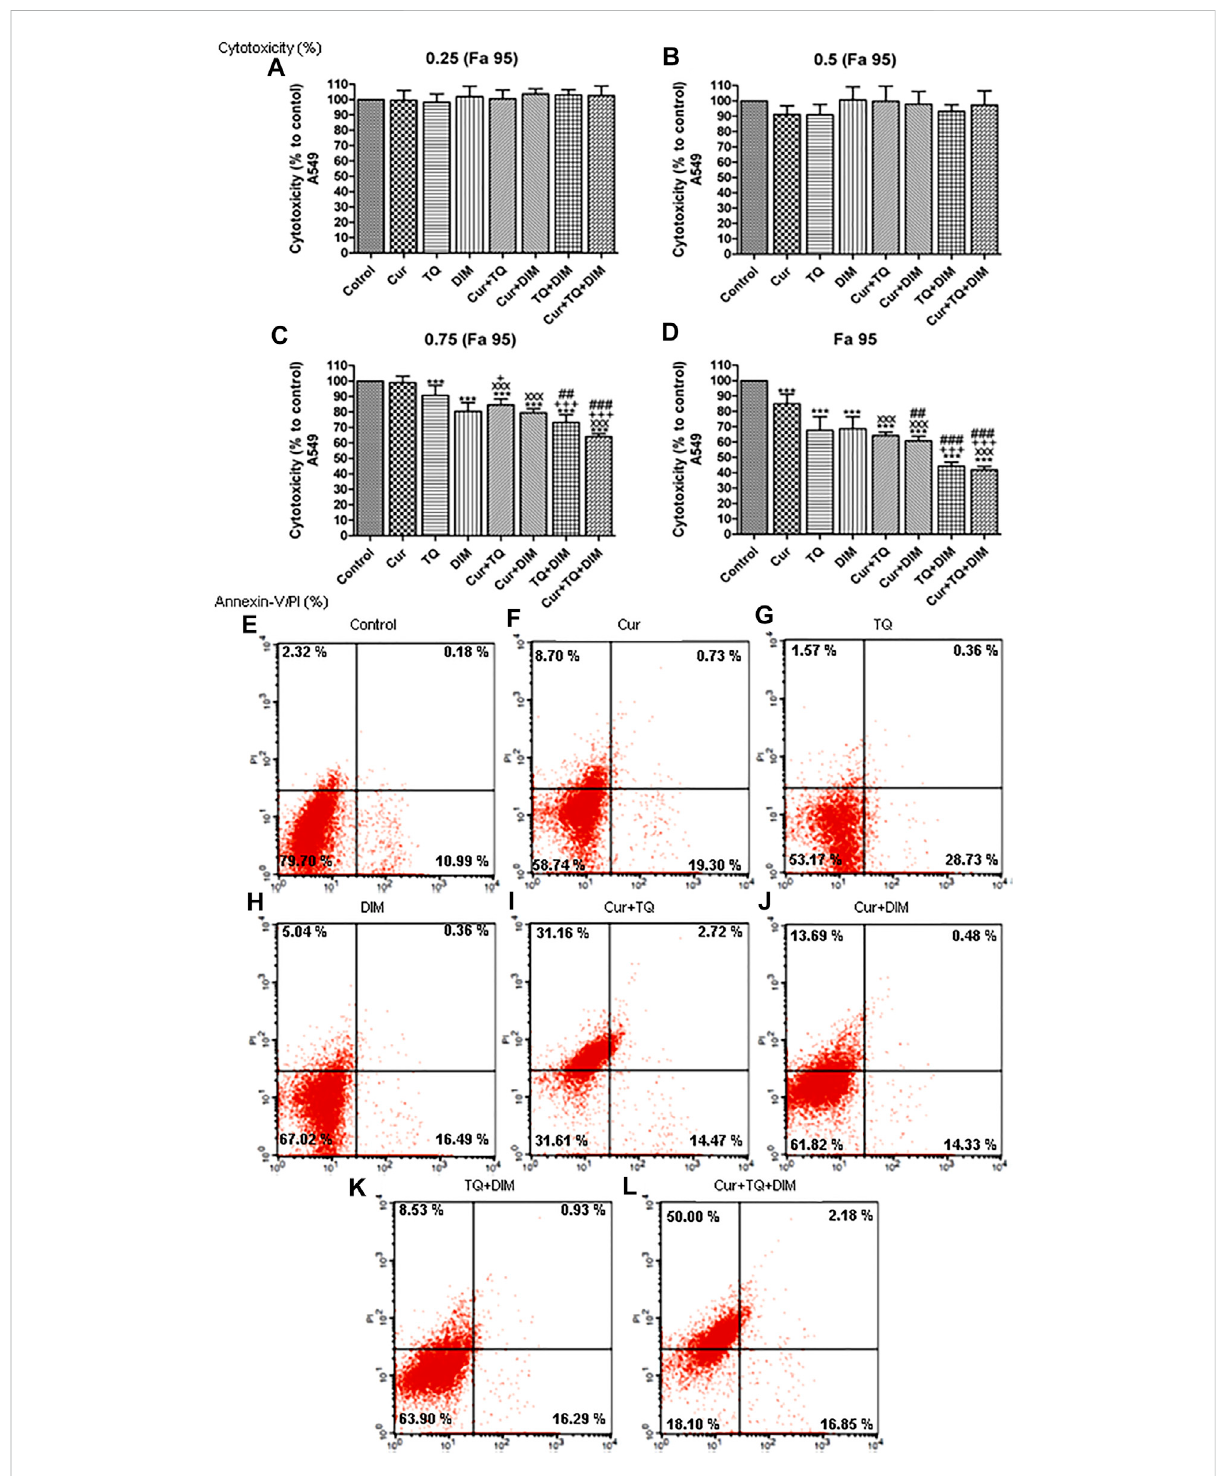
FIGURE 2 Cytotoxicity and annexin-V positive cell percentages of A549. (A) Cytotoxicity percentages of 0.25 (Fa 95), (B) 0.50 (Fa 95), (C) 0.75 (Fa 95), and (D) Fa 95 of curcumin (Cur), thymoquinone (TQ), and 3,3 ′ -diindolylmethane (DIM) against A549. (E) Annexin-V positive cell percentages of control A549 cells. (F) Cur-treated cells with 0.75 (Fa 95) = 9.53 µM. (G) TQ-treated cells with 0.75 (Fa 95) = 36.53 µM. (H) DIM-treated cells with 0.75(Fa95)=47.65 µM. (I) Cur+TQtreatedcellswith0.75(Fa95)ofCurandTQ. (J) Cur+DIMtreatedcellswith0.75(Fa95)ofCurandDIM. (K) TQ+DIMtreatedcellswith0.75(Fa95)ofTQandDIM. (L) Cur+TQ+DIMtreatedcellswith0.75(Fa95)ofCur,TQ,andDIM.Thedatawereanalyzed with one-way ANOVA followed by Tukey ’ s multiple comparison test. Error bars represent mean ± SD. *** p < 0.001 vs. control. xxx P < 0.001 vs. Cur. + p < 0.05 and +++ p < 0.001 vs. TQ. ## p < 0.01 and ### p < 0.001 vs.